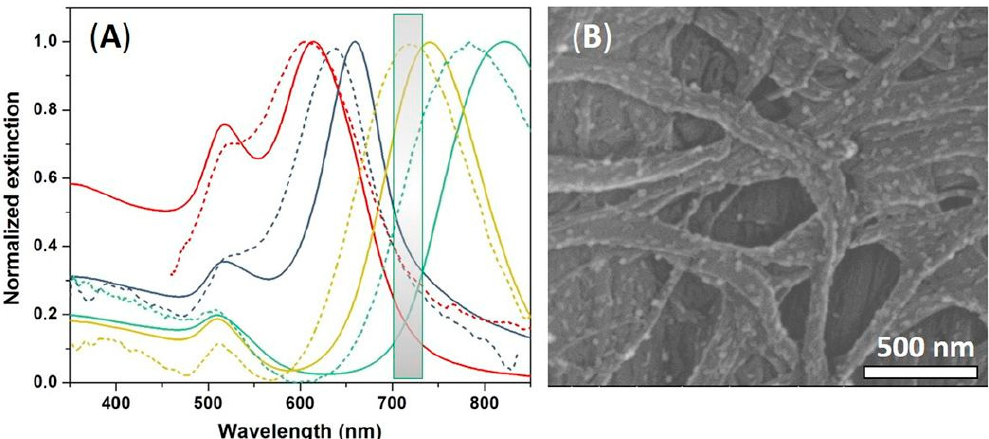
Figure 3. ( A ) Normalized extinction spectra of the GNRs with tunable LSPR response before (solid lines) and after the immobilization of the GNRs on the flexible paper platform (dotted lines); ( B ) representative SEM image of the plasmonic paper with a plasmonic response at 719 nm corresponding to the marked spectrum in Figure 3A.